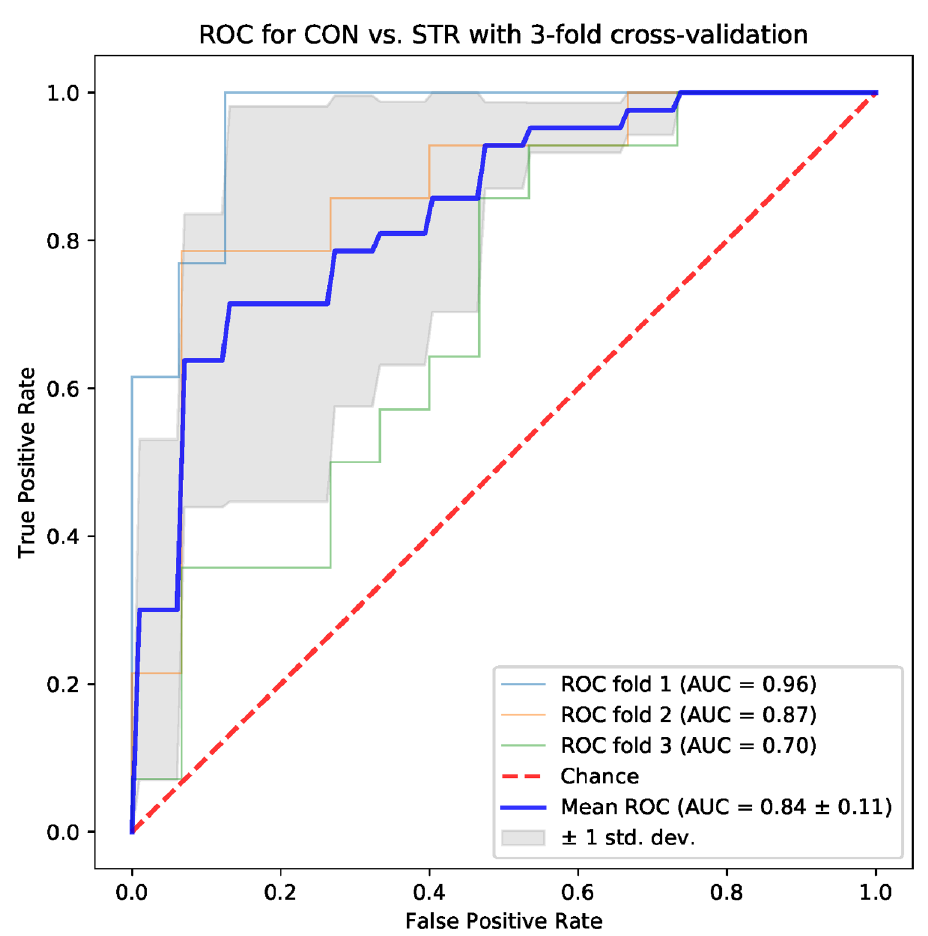
Fig 9. Results for the model trained with four topological parameters: Triangle width, number of intervals, length sum, frac 5%